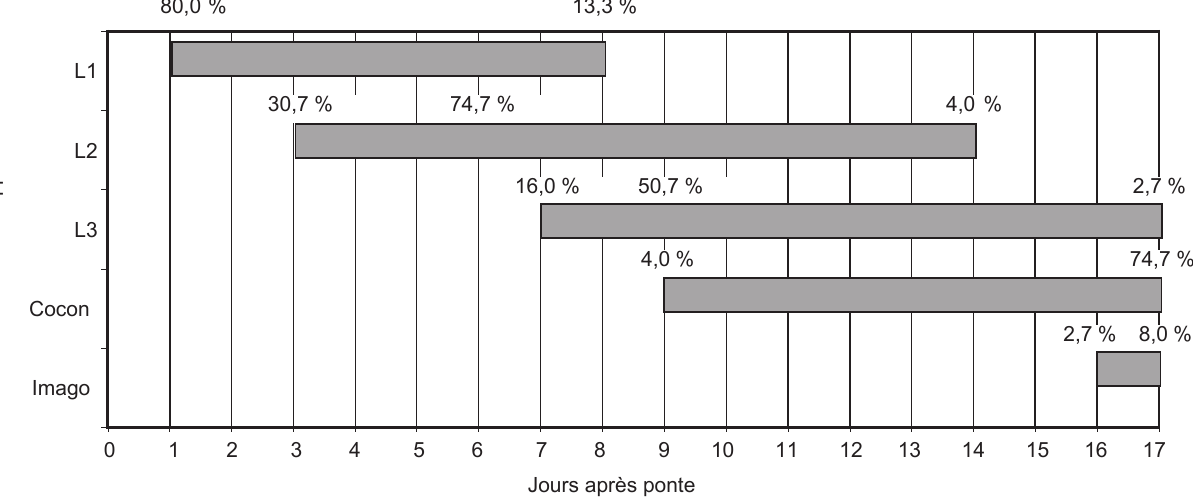
Fig. 3. – Chronologie d’apparition des différents stades de développement de C. f. strongylus à 29° C.